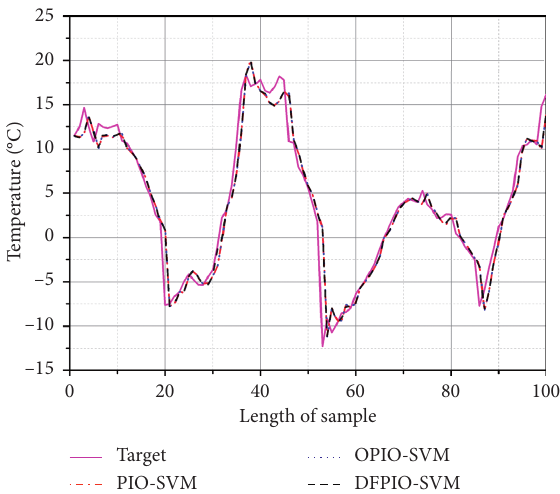
Figure 10: The target and prediction output for the temperature of PV panels.